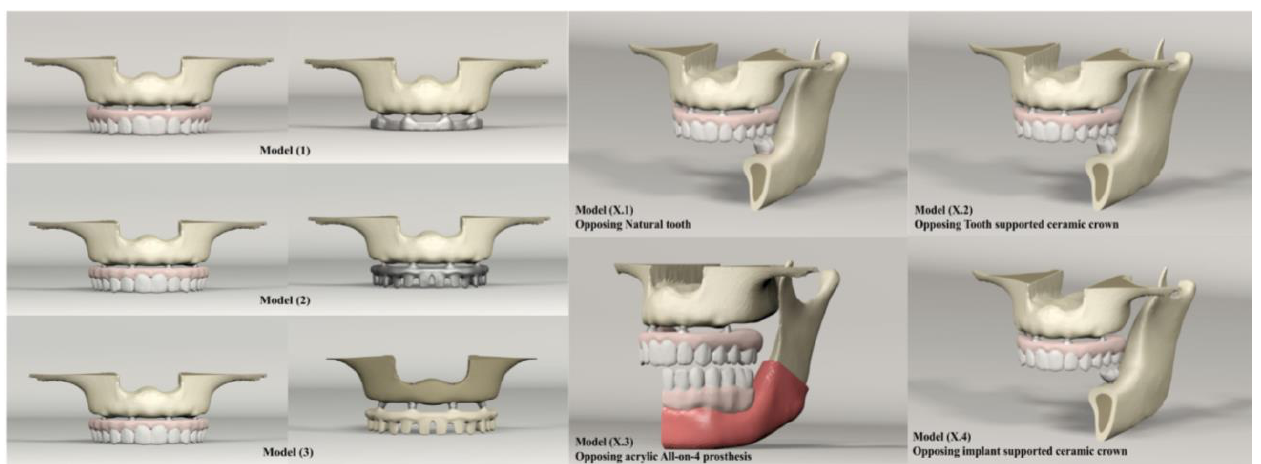
Figure 1. Maxillary and mandibular models used in the study. Table 2. Mechanical Properties of the